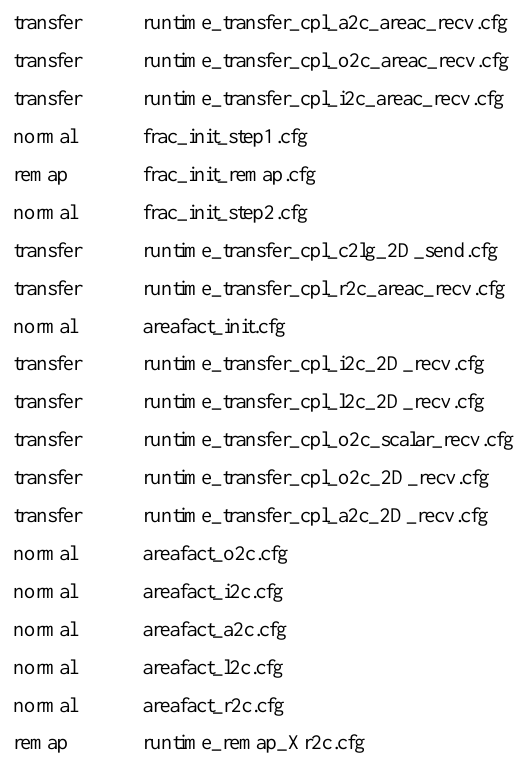
Figure 7. Part of the runtime configuration file of the algorithm list for the coupler component in FGOALS-gc. The first column specifies the type of each runtime algorithm. Transfer specifies the data transfer algorithms, remap specifies the data interpolation algorithms, and normal specifies the external algorithms. The second column specifies the configuration file of each runtime algorithm.